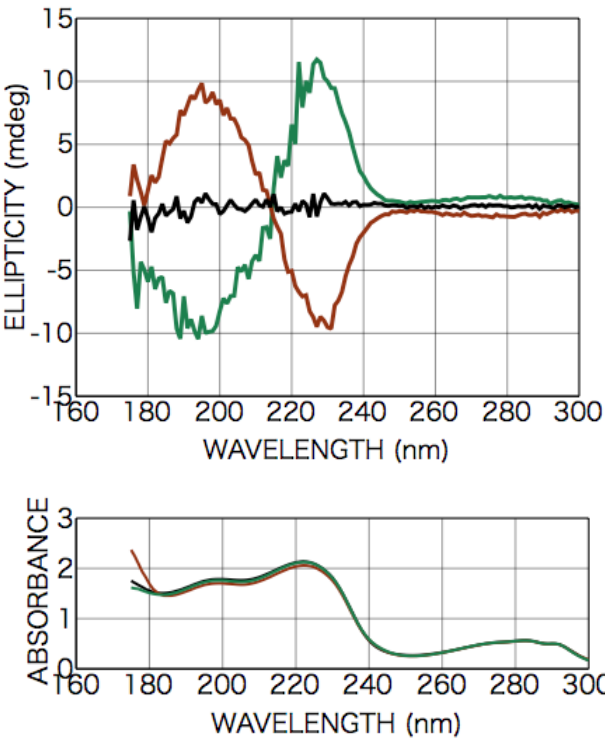
Figure 5. CD and photo absorption spectra of as-deposited D - (brown), L - (green), and DL - tryptophan (black) films (200-nm in thickness).